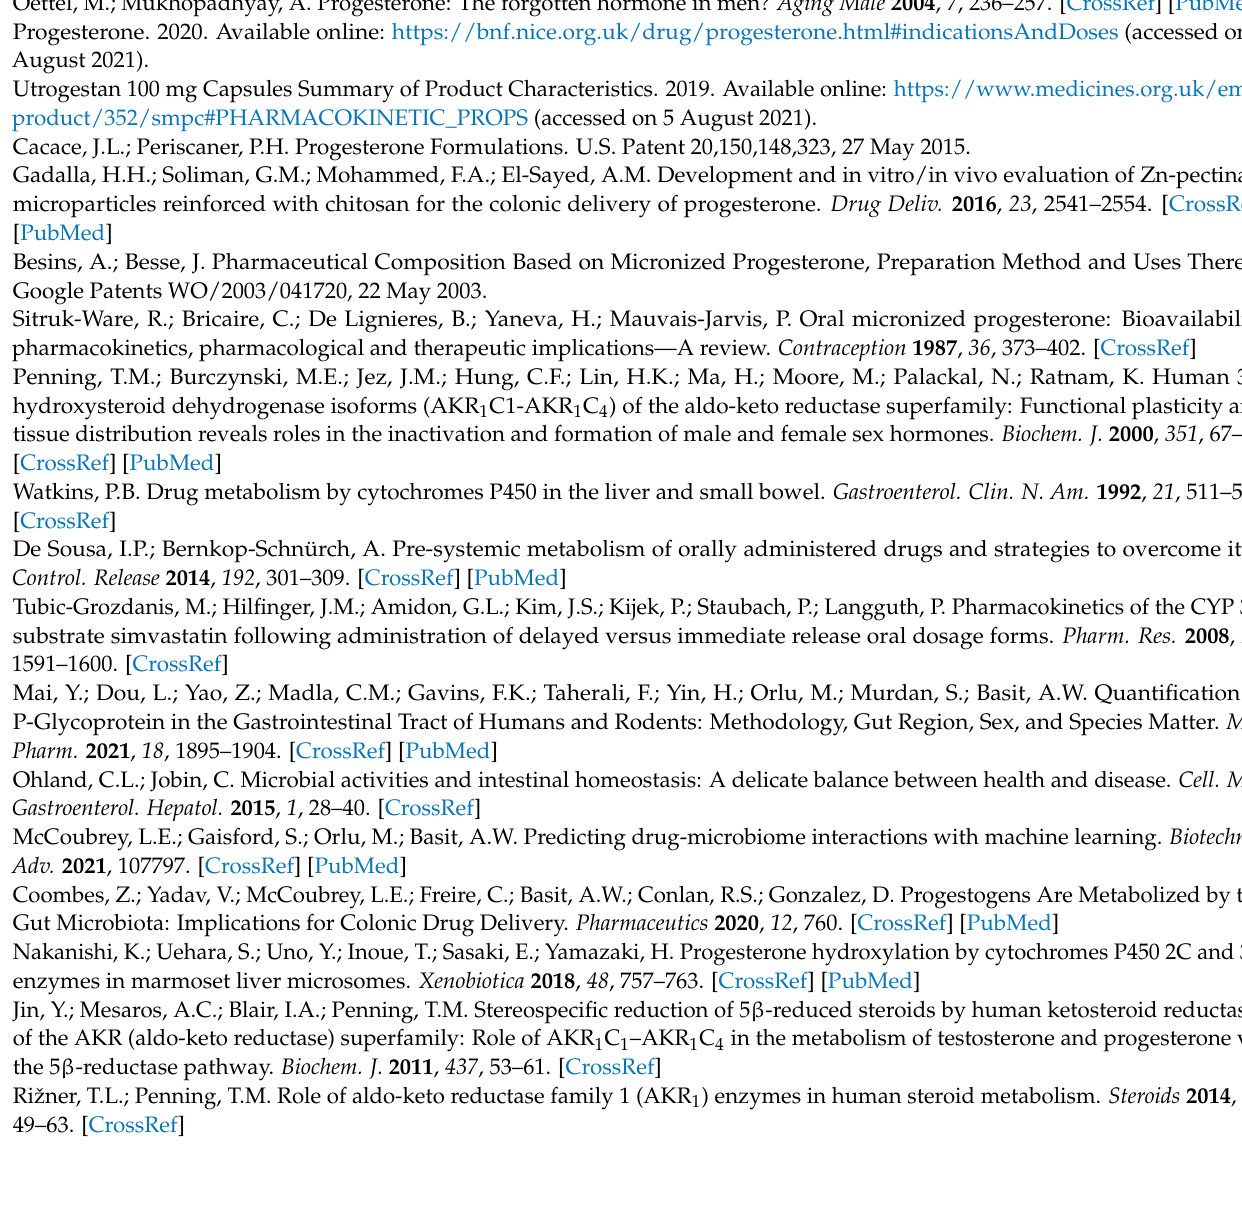
Figure A4. Concentration (expressed as percent of initial value) of progesterone as function of Figure A4 . Concentration (expressed as percent of initial value) of progesterone as func- incubation time with human liver cytosol and enzyme inhibitors, as tion of incubation time with human liver cytosol and enzyme inhibitors, as indicated.